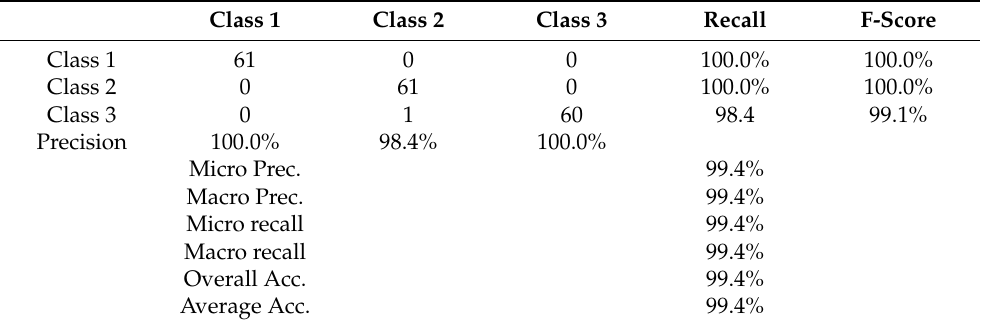
Table 9. Confusion matrix assessing CNN trained with “no or fewer shadows” images, tested with “no or fewer